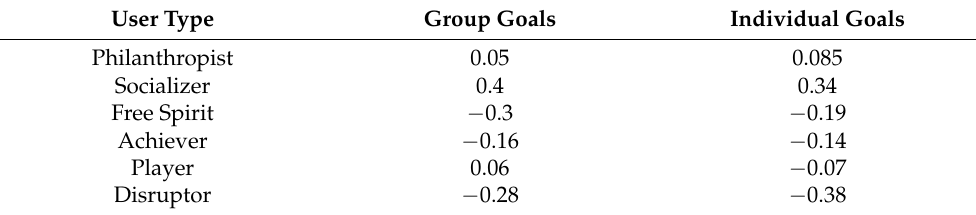
Table 4. Pearson coefficients for user types vs. kind of activities.